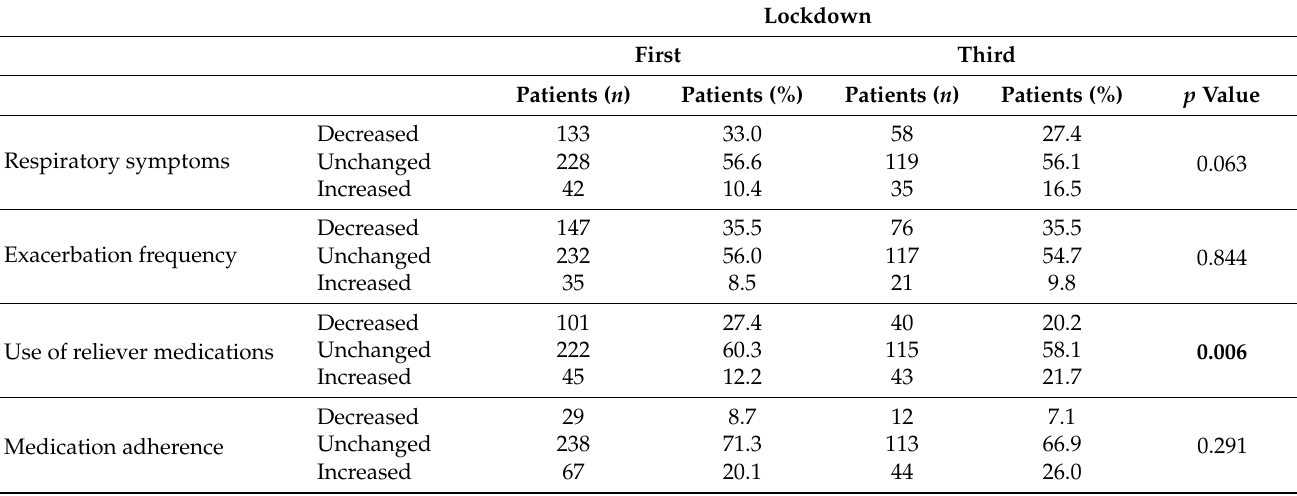
Table 2. Clinical status during